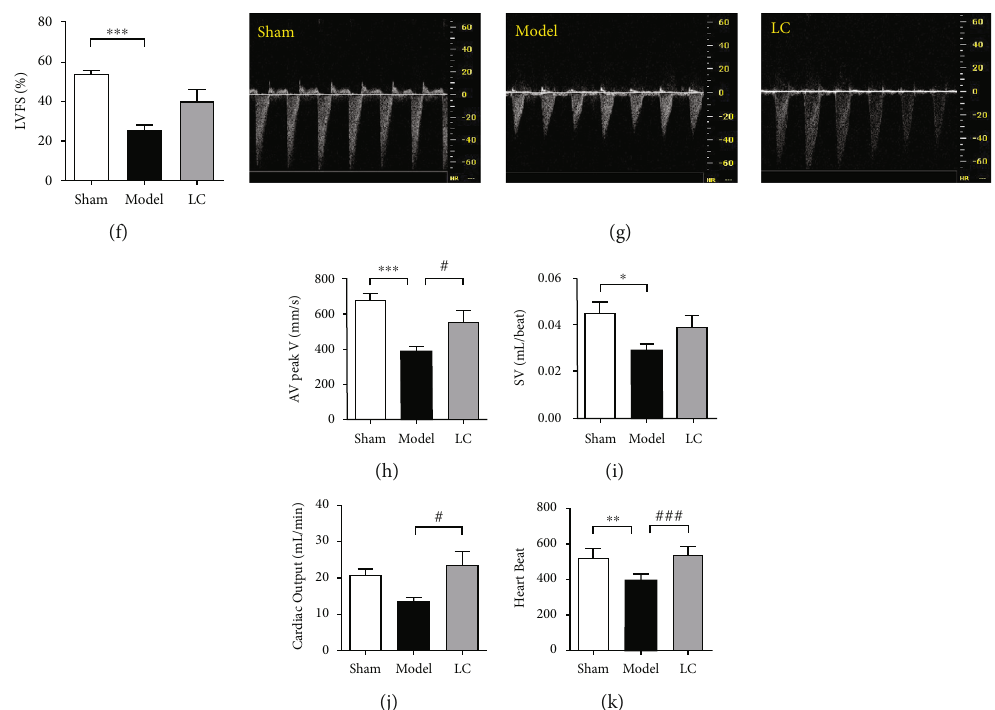
Figure 1: LC alleviated cardiac function of post-MI mice. (a) Representative ECG images of preoperation, postoperation, and 14 days after operation. (b) Representative M-mode tracing obtained at two weeks after surgery. (c) Left ventricular internal diameter at end-diastole (LVIDd). (d) Left ventricular end systolic internal diameter (LVIDs). (e) Left ventricular ejection fraction (LVEF). (f) Left ventricular fraction shortening (LVFS). Data were expressed as means ± SEM . n = 5 ; ∗ p < 0 : 05 , ∗∗ p < 0 : 01 , and ∗∗∗ p < 0 : 001 , compared to the sham group. # p < 0 : 05 , compared to the model group. (g) Ventricular tissue Doppler. (h) AV peak V (aortic valve peak velocity). (i) SV (stroke volume). (j) Cardiac output. (k) Heart rate. Values were expressed as means ± SEM . n = 5 ; ∗ p < 0 : 05 , ∗∗ p < 0 : 01 , and ∗∗∗ p < 0 : 001 , compared to the sham group. # p < 0 : 05 , ### p < 0 : 001 , compared to the model